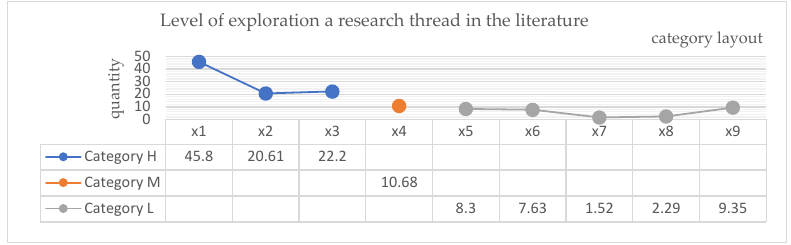
Figure 3. Level of exploration and research threads in the literature.